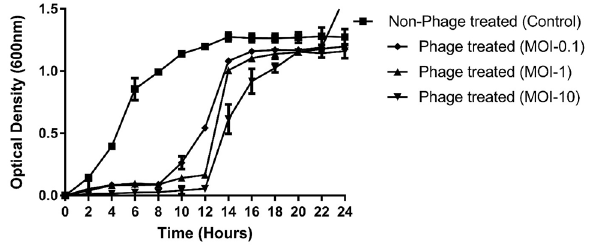
Figure 2. Determination of the invitro bacteriolytic activity of TSP bacteriophage. Phage-treated group: MRSA strain cocultured in logarithmic phase with TSP phage at an MOI of 0.1, MOI-1 and MOI-10. Control group: